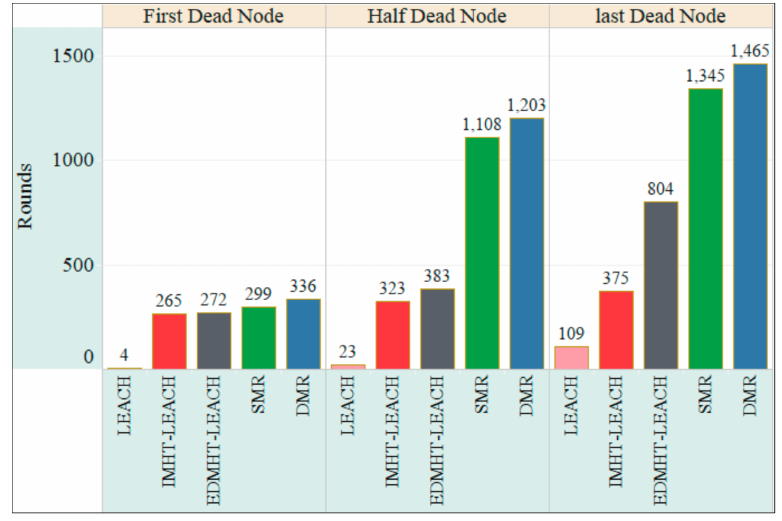
Figure 12. The stability of the network in the DMR, SMR, EDMHT-LEACH, IMHT-LEACH and conventional LEACH approaches versus the